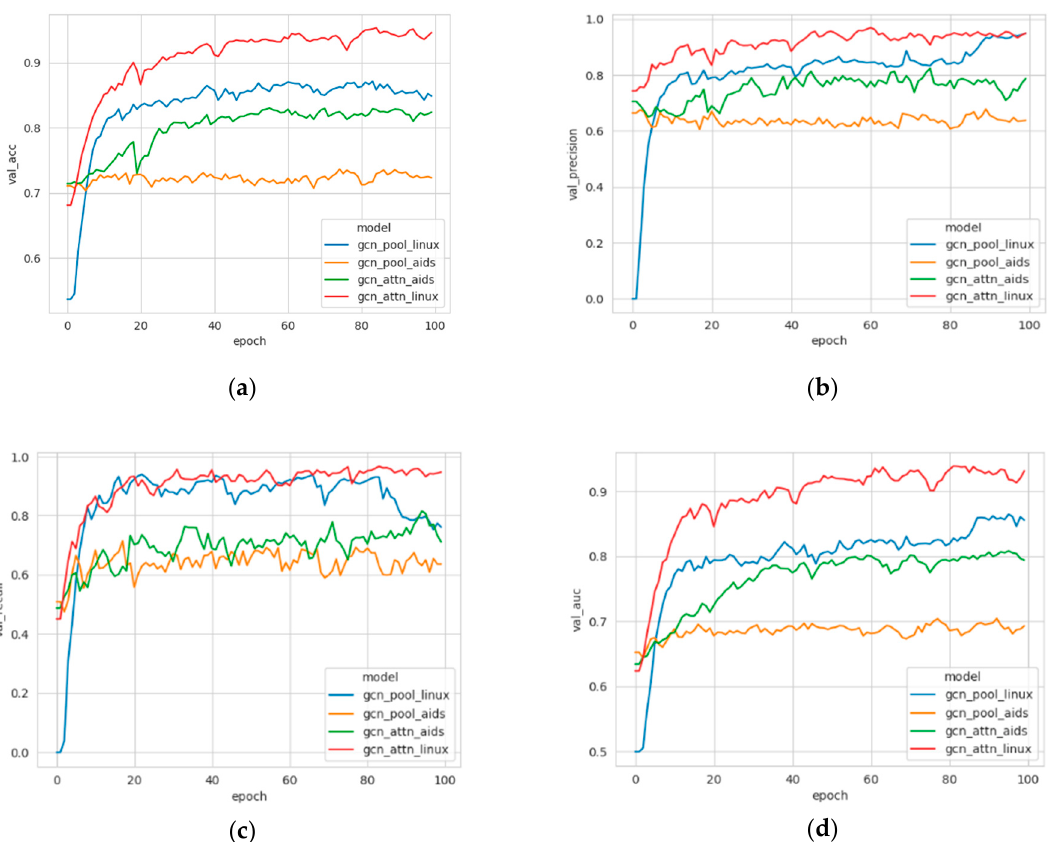
Figure 3. The curve comparison chart of the two models based on four evaluation metrics for the AIDS and LINUX datasets. ( a ) Accuracy ratio, ( b ) Precision ratio, ( c ) Recall ratio, ( d ) AUC index.